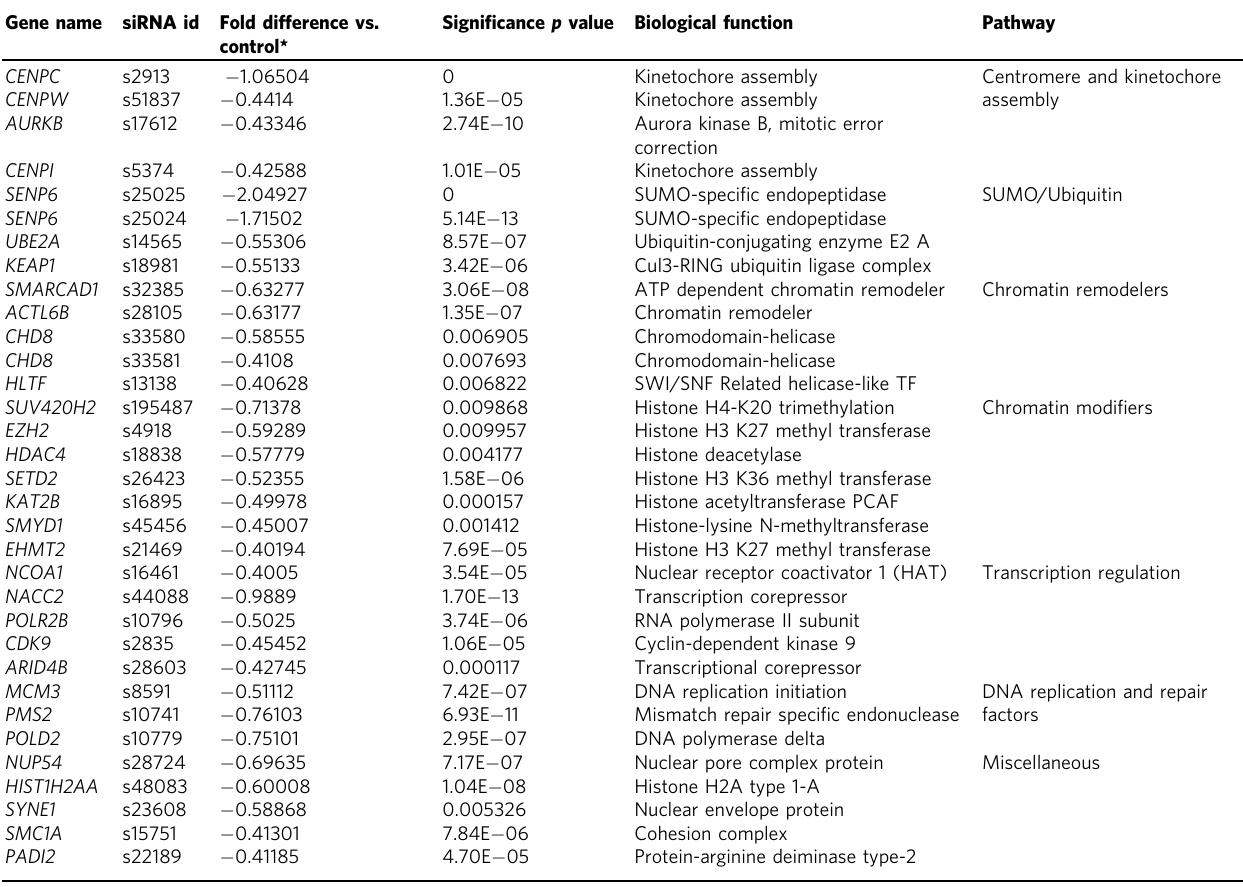
Table 1 List of candidate genes that affect the maintenance of ‘ old ’ CENP-A at the centromere. Gene name siRNA id Fold difference vs.